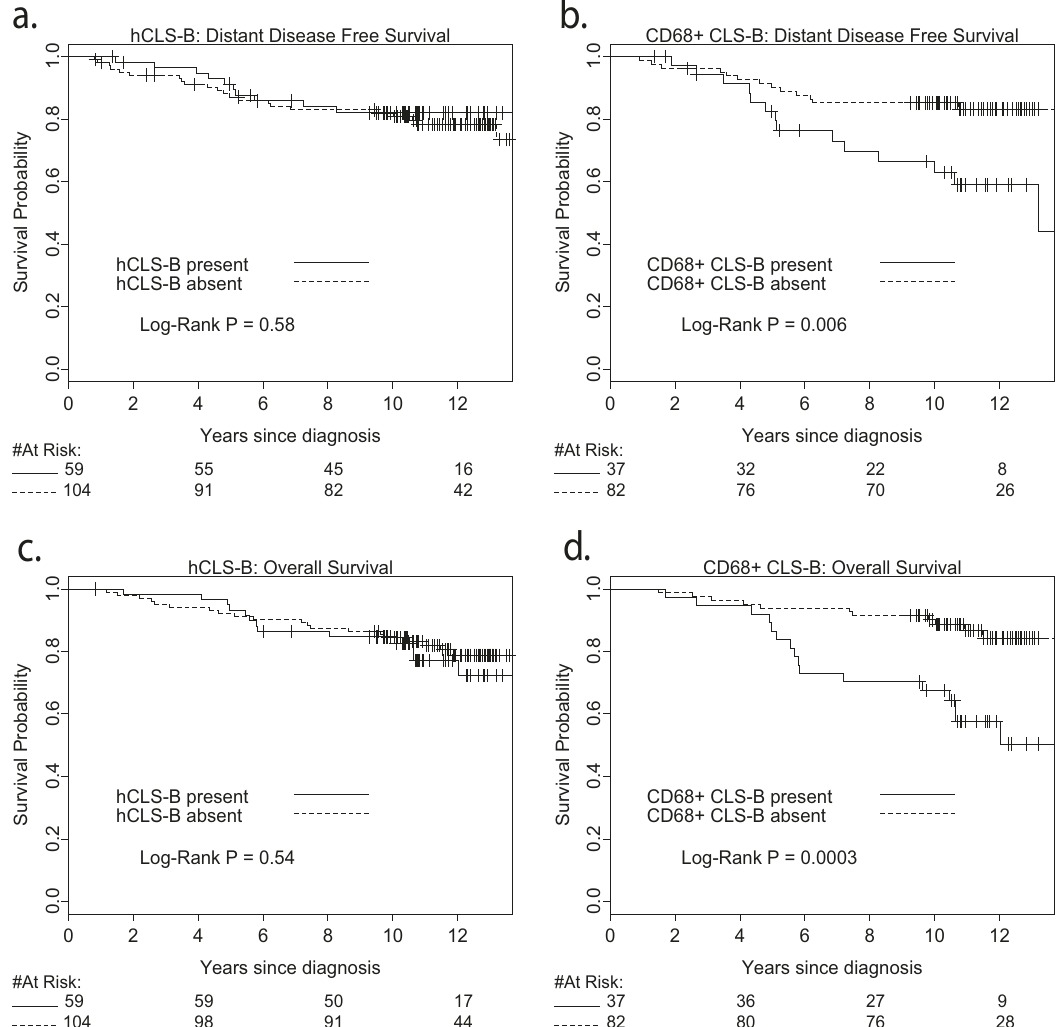
Fig. 3 Survival analysis shows prognostic signi fi cance of crown-like structures of the breast. Kaplan – Meier distant disease free ( a , b ) and overall survival plots ( c , d ) for the 163 patients assessed for H&E CLS-B ( a , c ) and the subset of 119 assessed by CD68 testing ( b , d while the presence of hCLS-B was associated with metabolic health without adverse prognosis. This adverse prognostic association of CD68 + CLS-B was independent of BMI and tumour factors such as grade, stage and hormone receptor status, but was attenuated when adjusted for metabolic factors. These differing metabolic responses, and associated prognostic associations, for CD68 + CLS-B and hCLS-B may re fl ect differences in macrophage maturity and diversity that are independent of BMI, or potentially other factors not investigated here, including the occurrence of cells other than macrophages in the hCLS-B. Further research is needed to replicate these results and to understand the biologic basis for the differing tissue and metabolic responses to obesity.